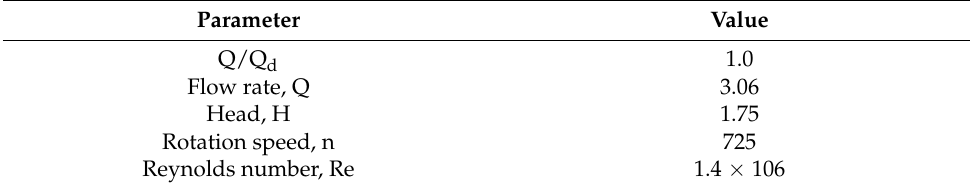
Table 2. Flow specifications of working